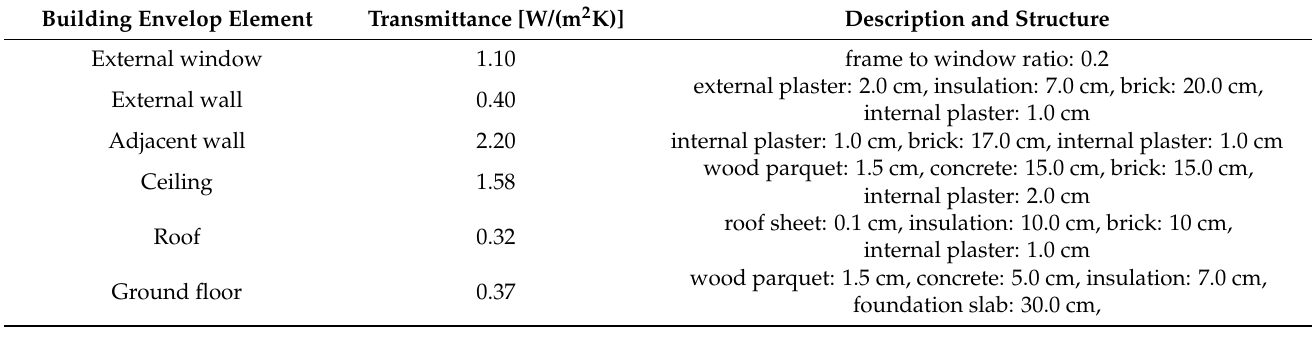
7.0 cm, foundation slab: 30.0 cm,